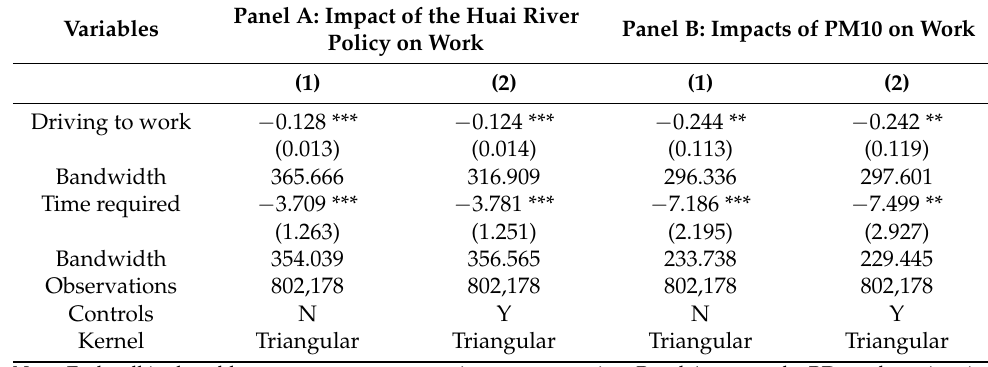
Table A3. RD estimates of the impacts on the alternative work measure.